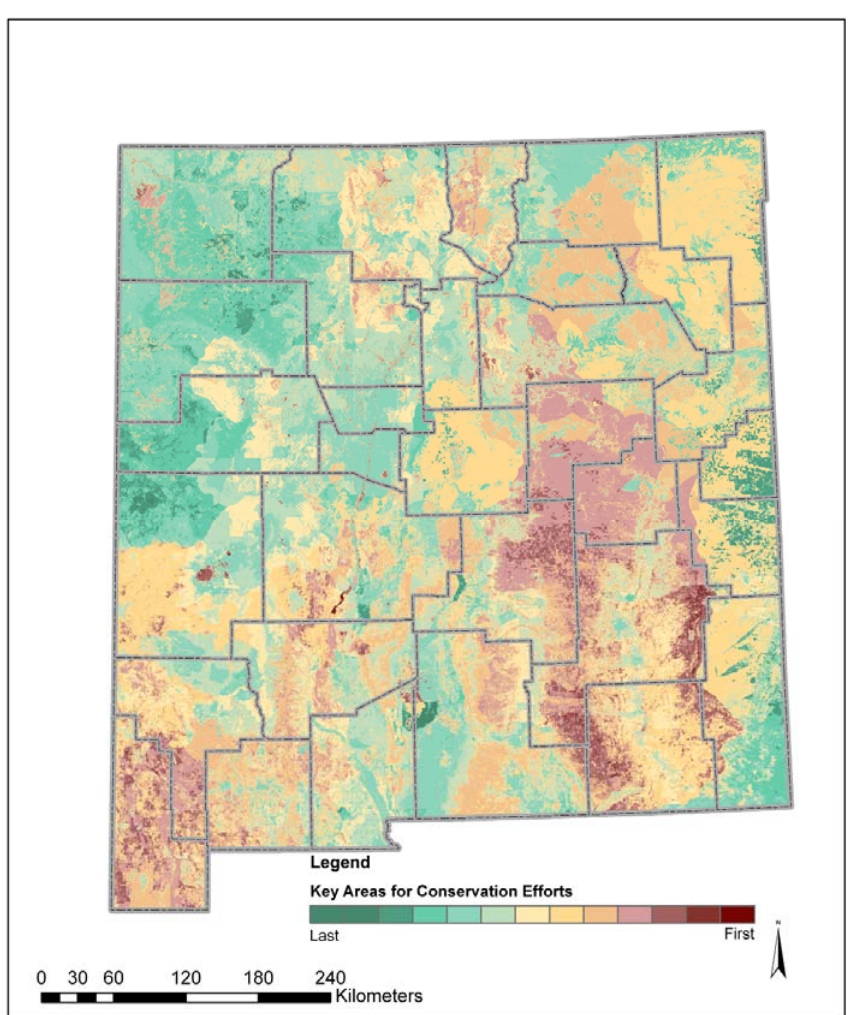
Figure 8 . Key areas to consider for planning conservation efforts. This spatial representation is designed to enhance our understanding of geographic areas where conservation efforts may be needed. This analysis should not be used to locate small parcels of